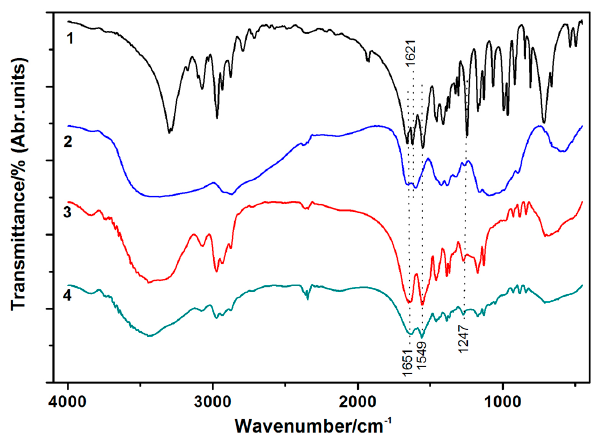
Figure 3. FT-IR spectra of: ( 1 ) NIPAAm; ( 2 ) chitosan; ( 3 ) PNIPAAm; and ( 4 ) IPN PNIPAAm/CS hydrogel (IPN-3).